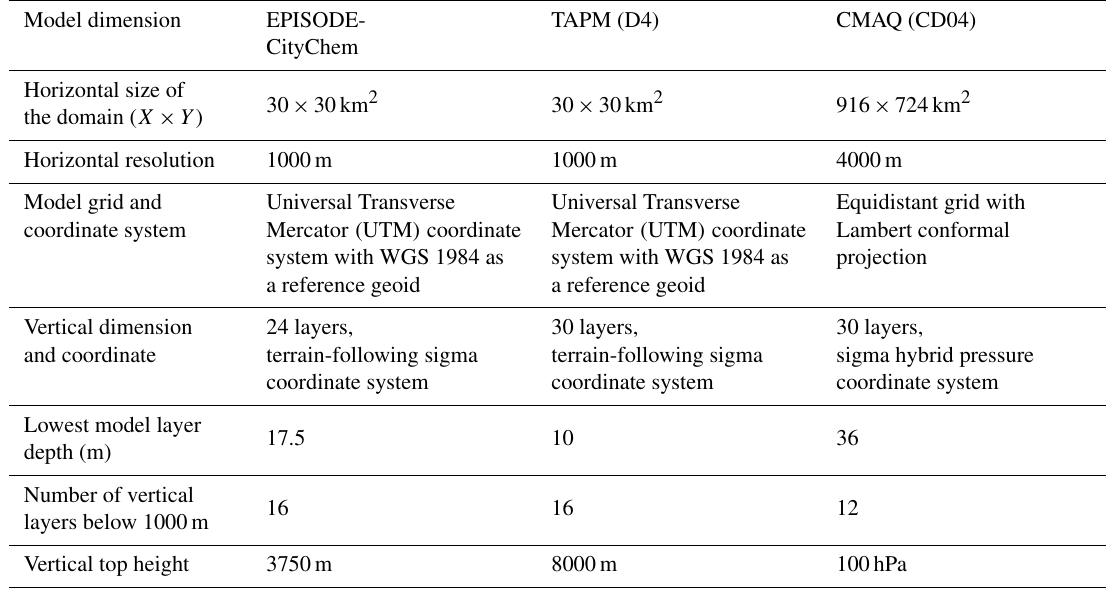
Table 5. Vertical and horizontal structure of the 3-D Eulerian grid of the EPISODE–CityChem model and comparison with TAPM (D4) and CMAQ (CD04) for the simulation of AQ in